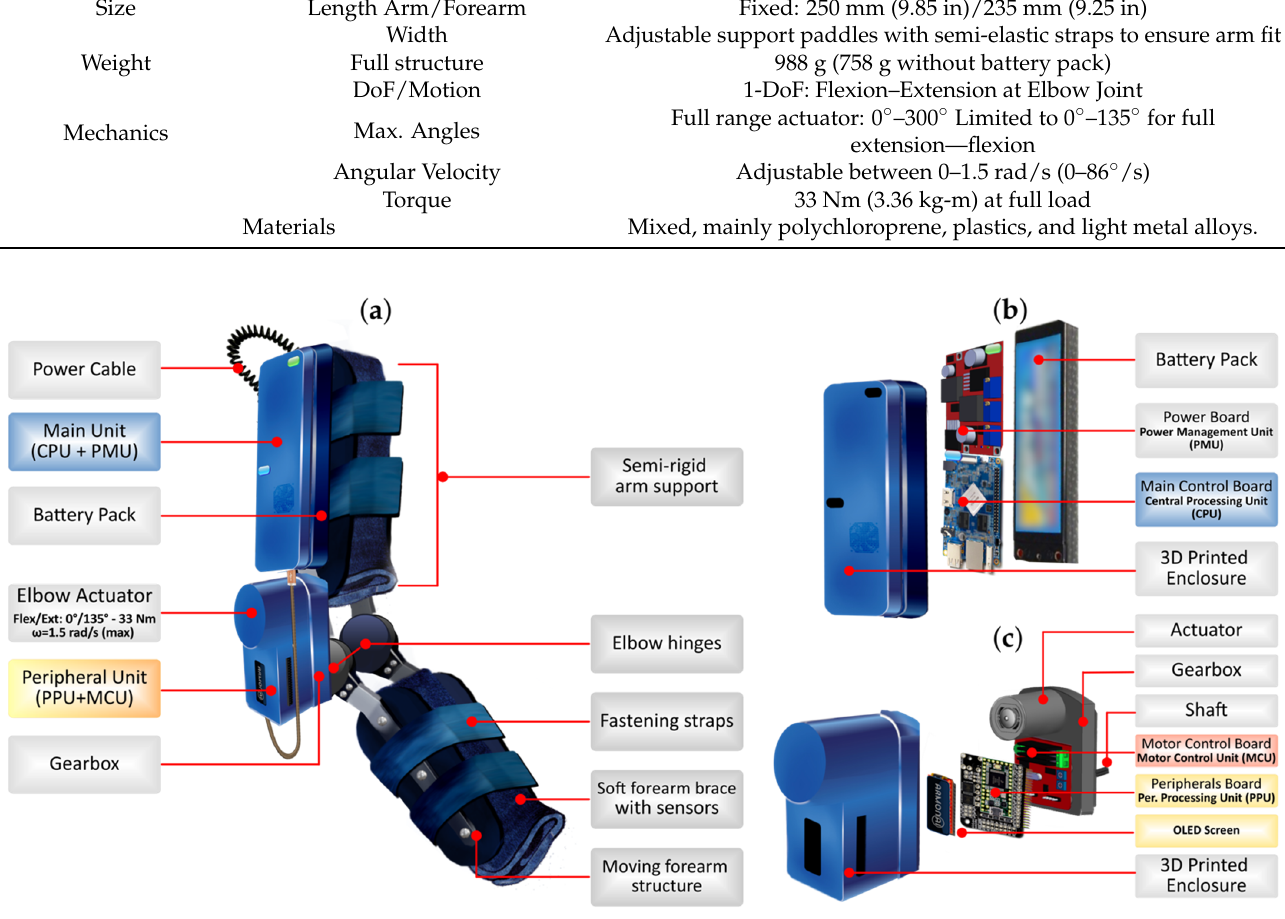
Figure 2. Physical design and main parts of the exoskeleton prototype: ( a ) fully assembled device (sagittal plane); ( b ) Main Unit (exploded-view drawing); and ( c ) Peripheral Unit and the actuation system (exploded-view drawing). Table 1. Summary of the physical and mechanical characteristics of the exoskeleton prototype.